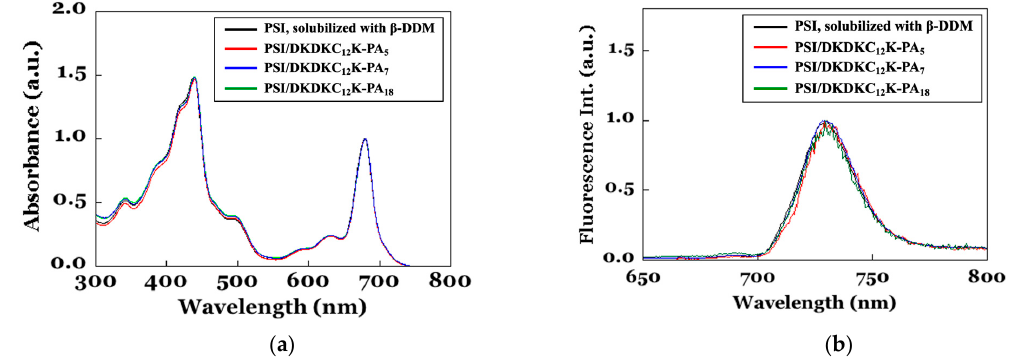
Figure 2. Absorption and fluorescence spectra of PSI, solubilized with 0.1 wt% β -DDM, or conjugated with DKDKC 12 K-PA n ( n = 5, 7, 18). ( a ) Absorption spectra of PSI, solubilized with 0.1 wt% β -DDM (black), DKDKC 12 K-PA 5 (red), DKDKC 12 K-PA 7 (blue), and DKDKC 12 K-PA 18 (green). ( b ) Florescence spectra of PSI, solubilized with 0.1 wt% β -DDM (black), DKDKC 12 K- PA 5 (red), DKDKC 12 K-PA 7 (blue), and DKDKC 12 K-PA 18 (green).